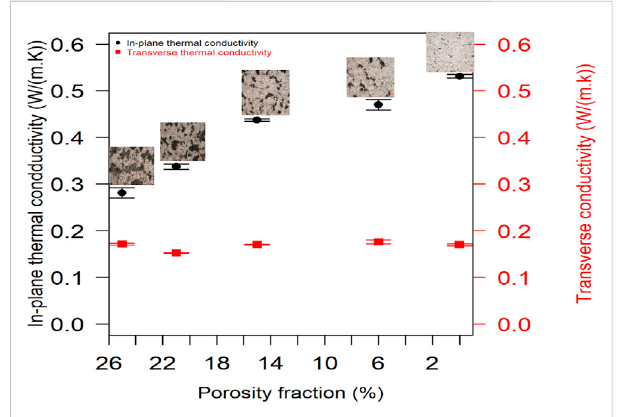
FIGURE 13 Measured thermal conductivity in in-pane and transverse directions at different consolidation stages. The transverse thermal conductivity isperpendiculartotheaxisofFlax/PP fi bres.The in-plane thermal conductivity is along the axis of Flax/PP fi bres.